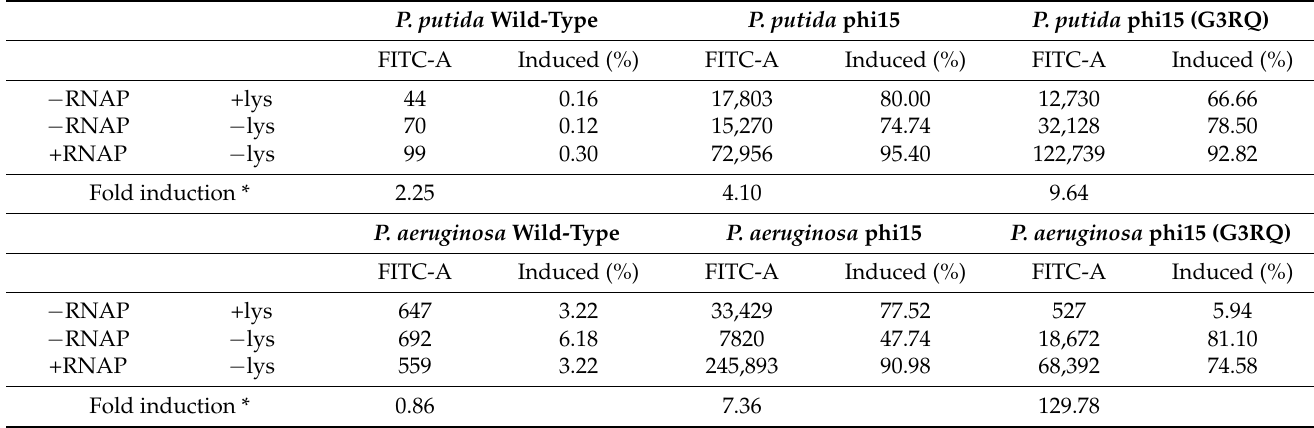
Table 1. Flow cytometry data of the phi15 expression system in P. putida and P. aeruginosa . Wild-type P. putida KT2440 and P. aeruginosa PAO1 strains (wild-types), P. putida and P. aeruginosa with the phi15 RNAP, phi15 reporter construct, and phi15 lysozyme (phi15), and P. putida and P. aeruginosa with the phi15 RNAP, phi15 reporter construct, and phi15 lysozyme (G3RQ) mutant (phi15(G3RQ)) were induced overnight with 5 mM Rha (+lys) or 0.3 mM 3mBz (+RNAP), after which 5000 cells were analyzed with flow cytometry for FITC-A, as described in Section 4. Cells with a FITC-A level above 10 4 are considered induced, whereas cells below 10 4 are uninduced. Column FITC-A depicts the median FITC-A value of the entire cell population, and column induced (%) depicts the percentage of cells of the entire population that have a FITC-A value above 10 4 . Complete histograms of the corresponding data are available in Figures S10 and